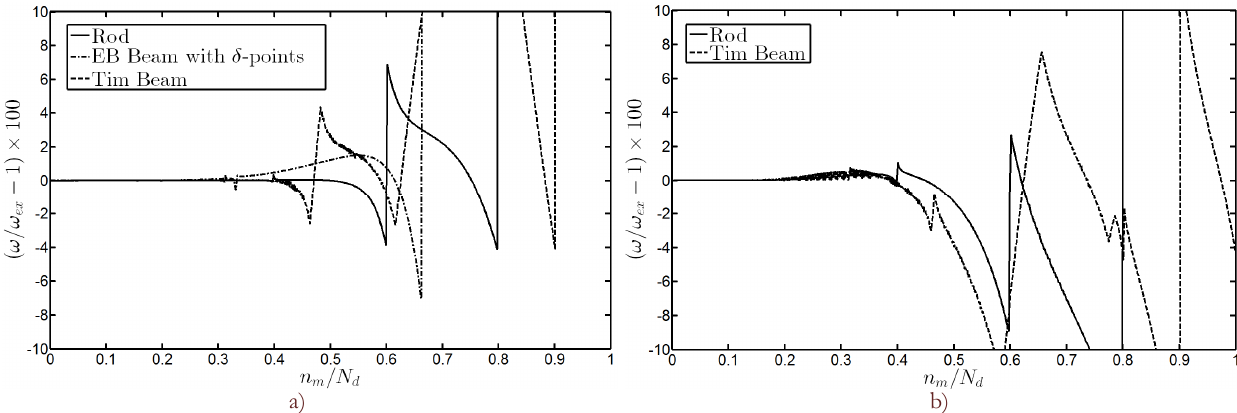
n  for a CC Rod, a SS EB beam with e n  for a CC Rod and a CC Tim beam using PDQ e